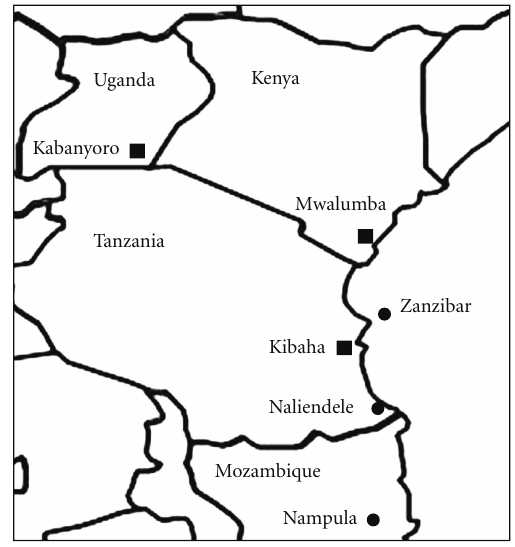
Figure 1: A sketch map of eastern Africa showing the collection sites of CBSV (circles) and CBSUV (squares) isolates used in symptom diversity